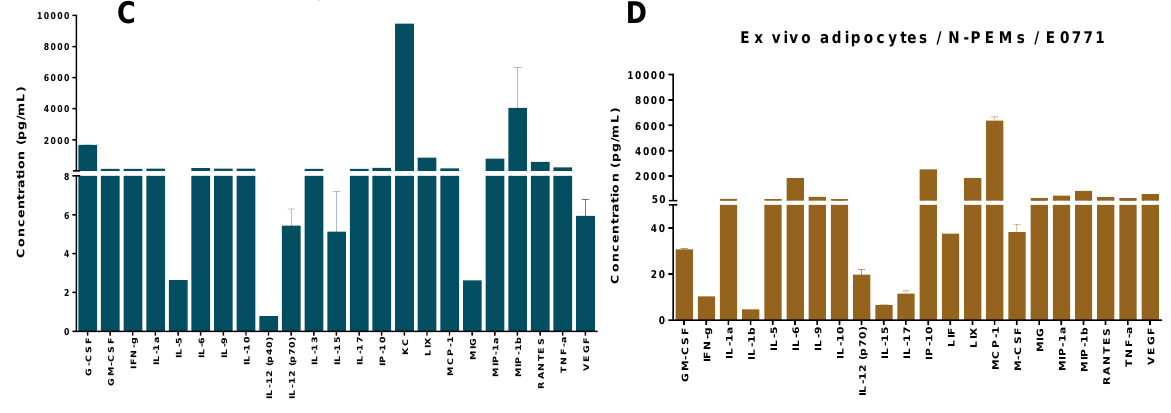
Figure 5. Cytokines, chemokines and growth factors detected in cell supernatants from adipocytes, mammary tumor cells, macrophages and their co-cultures. 48 h supernatants from the three different cell types and their co-cultures were analyzed for cytokines, chemokines and growth factors using Luminex analysis. ( A ) Comparison of the proteins secreted by in vitro differentiated 3T3-L1 adipocytes and ex vivo isolated adipocytes, showing statistical differences (Student’s t- test) between the two types of adipocytes compared to each other. ( B ) Cytokines/chemokines/chemokines/growth factors detected in E0771 cell supernatants. ( C ) Cytokines/chemokines/growth factors secreted by peritoneal elicited macrophages. ( D ) Cytokines/chemokines/growth factors secreted by co-cultures between ex-vivo isolated adipocytes, macrophages and E0771 mammary tumor cells. Data are representative of one of two independent experiments showing similar results; each sample was tested in